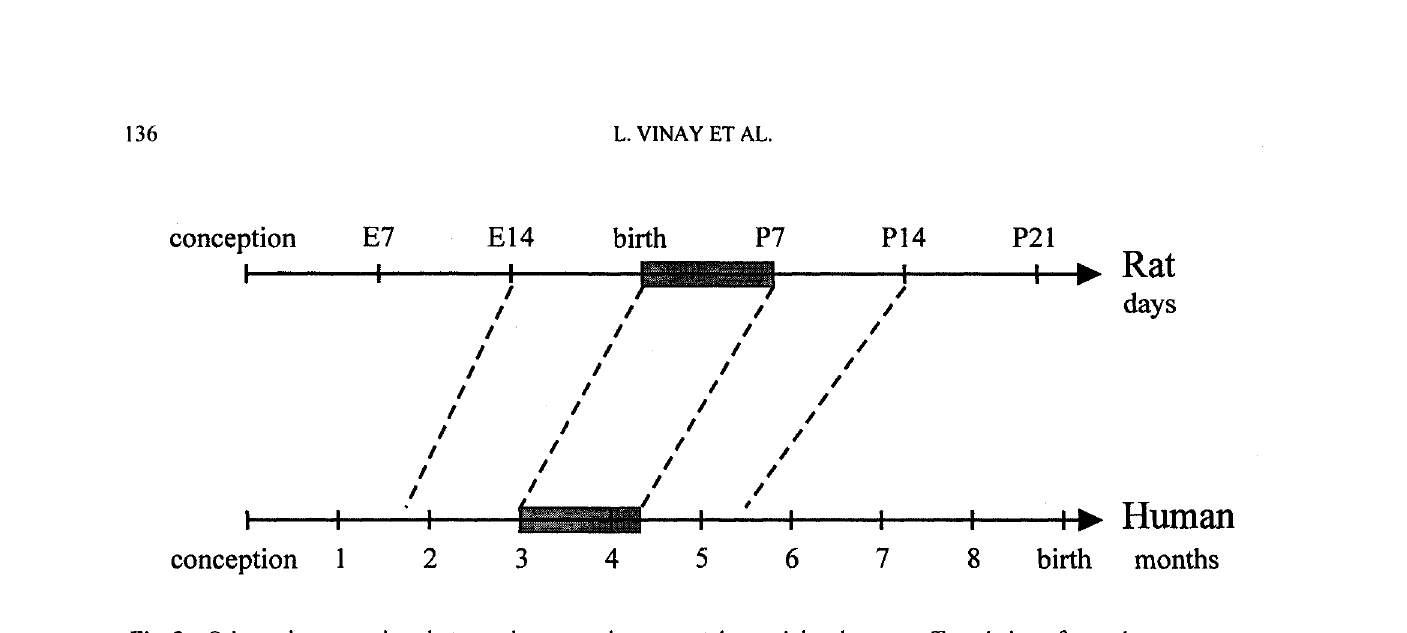
Fig. 2: Schematic comparison between human and rat prenatal neural developments Translation of neural developmental times is based on the model proposed by Clancy et al. (2001). The grey rectangle represents the time window which is critical for the arrival of descending pathways particularly serotoninergic projections in the lumbar enlargement. The first postnatal week in the rat corresponds roughly to the fourth month in the human